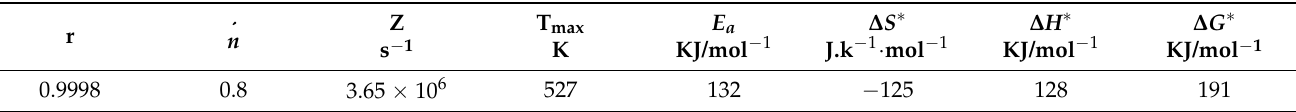
Table 1. Kinetic parameters of Coats–Redfern (CR) equation for compound 4 .